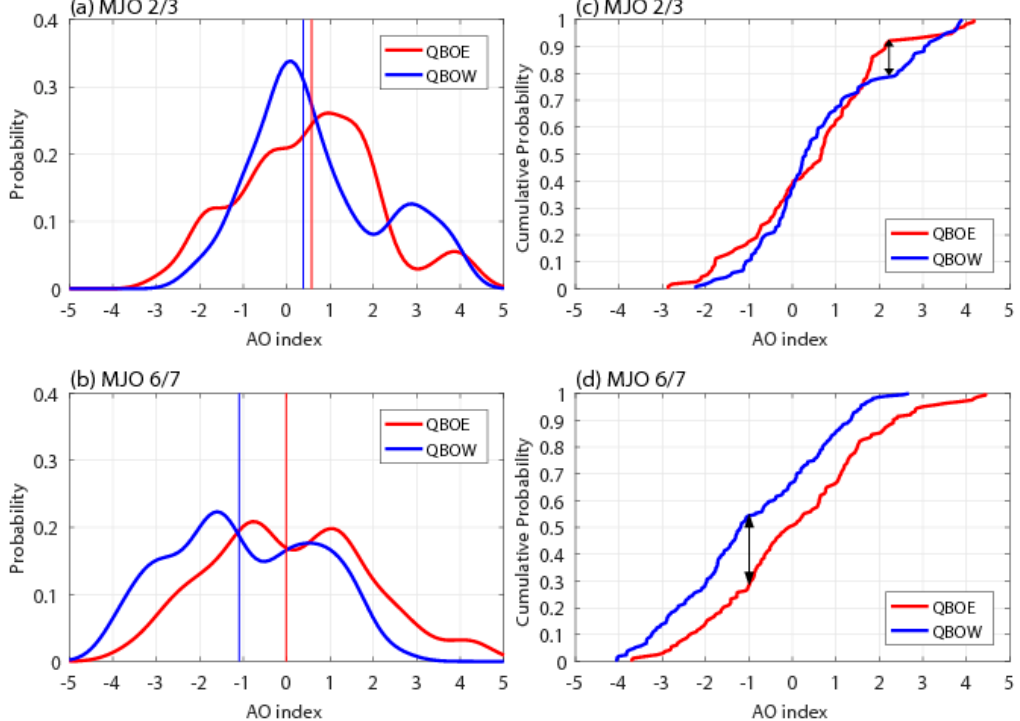
Figure 1. The probability density function (PDF) of the Arctic Oscillation (AO) index when the Madden–Julian oscillation (MJO) phases 2/3 (a) and 6/7 (b) lead the AO for 10 to 14 days. The red and blue vertical lines represent the median values of the PDFs in QBOE and QBOW years, respectively. Two-sample Kolmogorov–Smirnov statistics for PDFs in ( a ) and ( b ) are presented in ( c ) and ( d ), respectively. Red and blue lines indicate the empirical distribution function in QBOE and QBOW years, respectively. The black arrows are the two-sample Kolmogorov–Smirnov statistic.